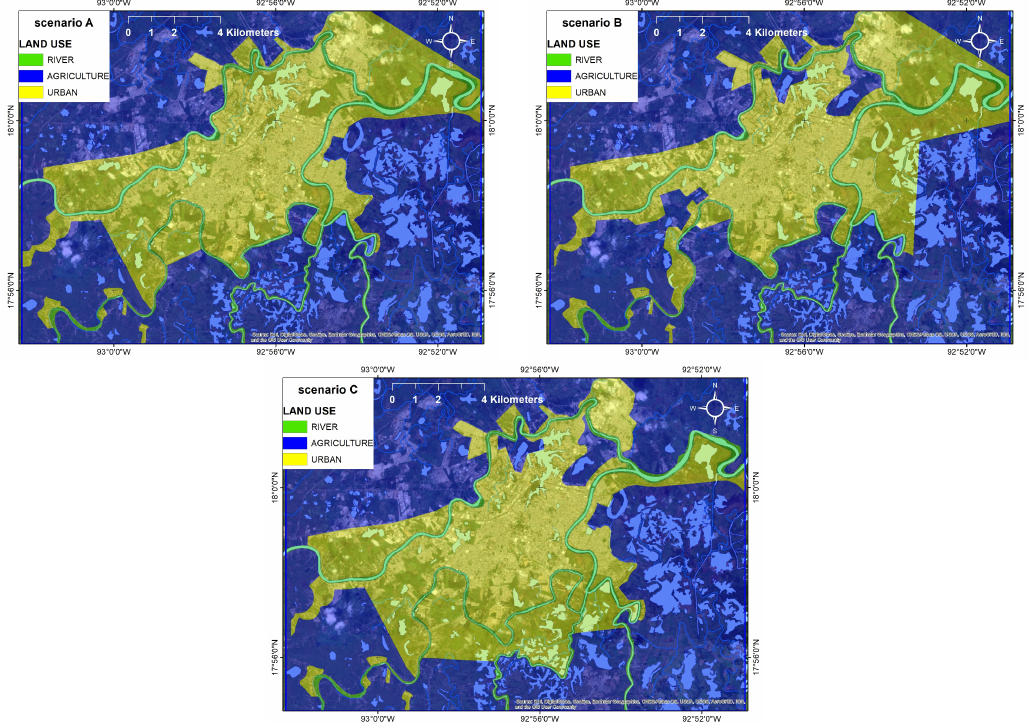
Figure 7. Proposed urbanization scenarios in the city of Villahermosa for